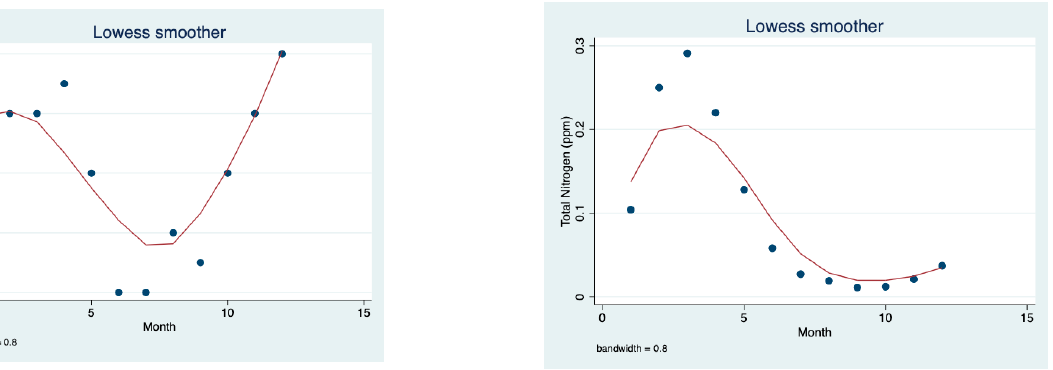
Figure 17. Lowess smoother (0.8 bandwidth) trend of changes plot of monthly changes of ammonium (left) and total orthophosphate (right) concentrations (ppm scale range: Ammonium—0.05–0.3; P-Otho—0.00–0.020) (1969–2001).